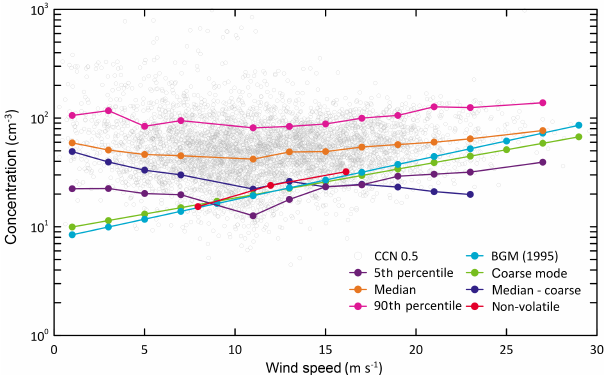
Figure 5. CCN0.5 concentration as a function of wind speed, win- ter, radon <150mBeqm − 3 . BGM (1995) is the CCN active at 0.6% supersaturation observed by Bigg et al.